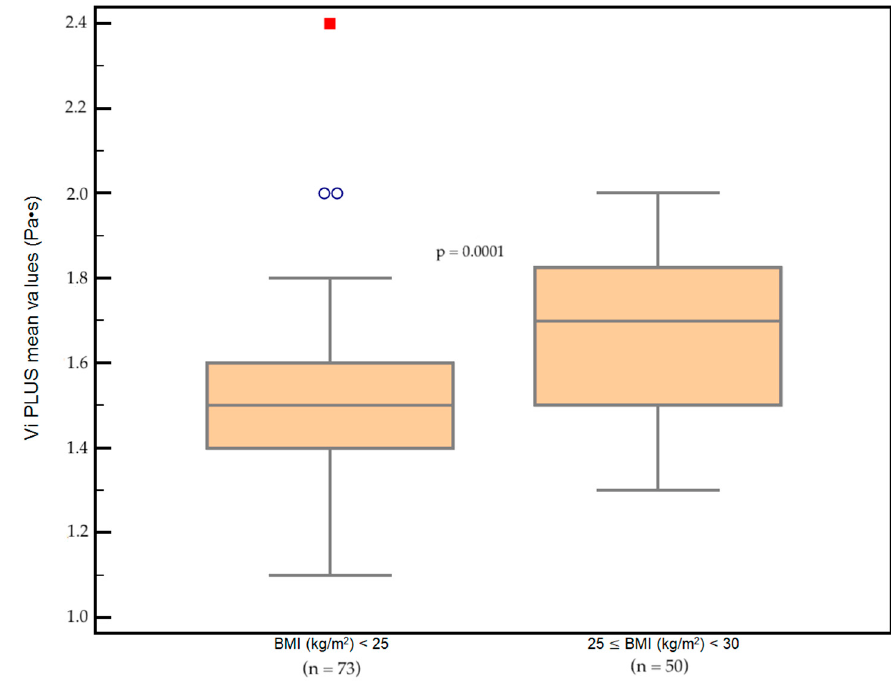
Figure 5. Box-and-whisker distribution plots comparing Vi PLUS values according to BMI. Vi PLUS values were significantly higher in overweight subjects ( p = 0.0001). The two small blue circles and the red square are the graphical representation for outliers (an extremely high or extremely low value).